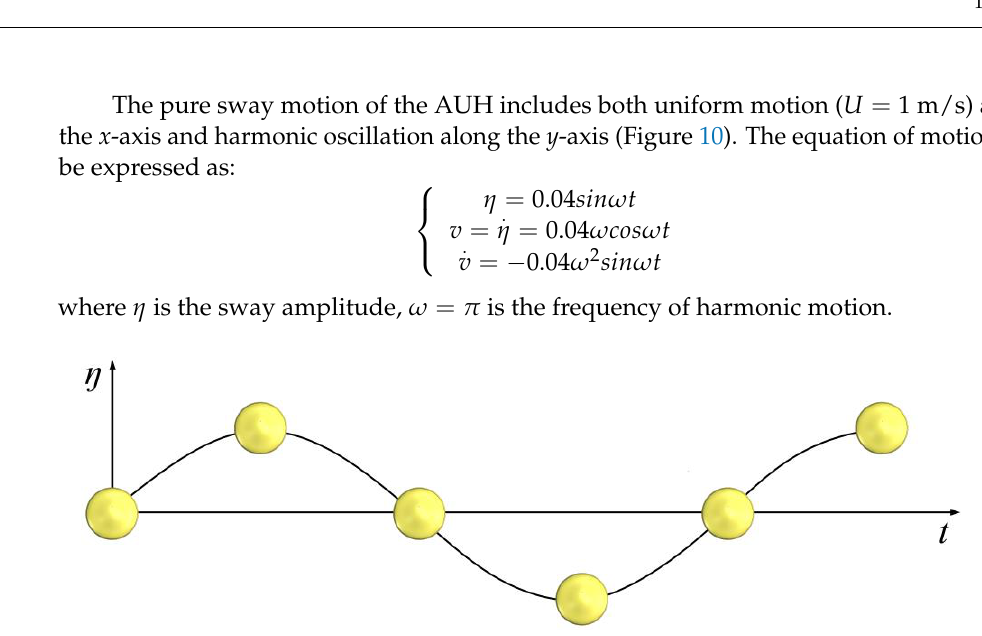
Figure 10. Diagram of the pure sway motion of AUH. Substituting the above equation into Equation (11), the hydrodynamic force Y in the y -direction and the hydrodynamic moment N around the z -axis can be